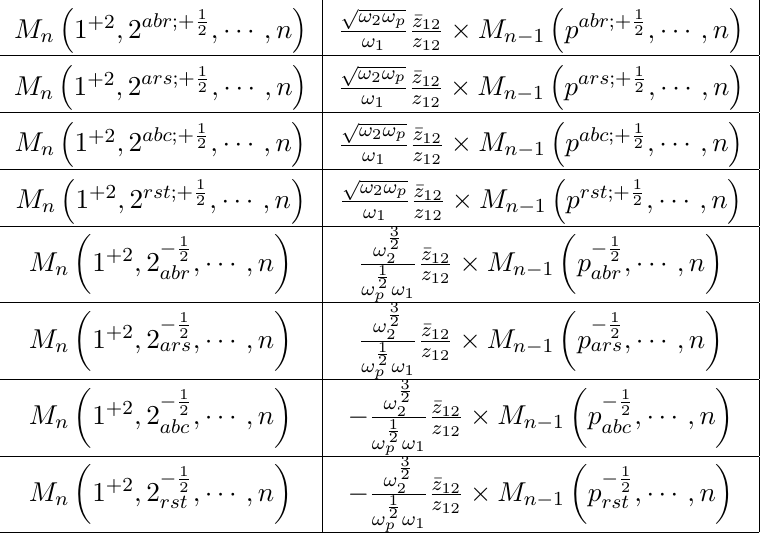
Table 10 . Amplitude corresponding to collinear graviton and